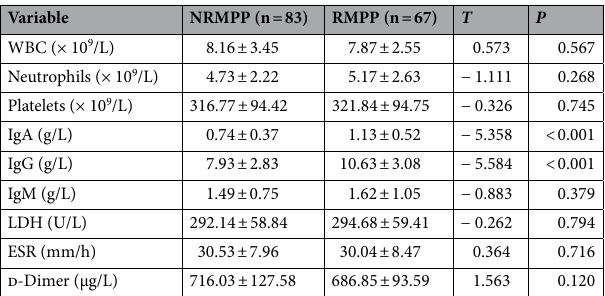
Table 2. Comparison of clinical and biochemical between NRMPP and RMPP Patients. WBC white blood cell count, LDH lactate dehydrogenase, ESR erythrocyte sedimentation rate.